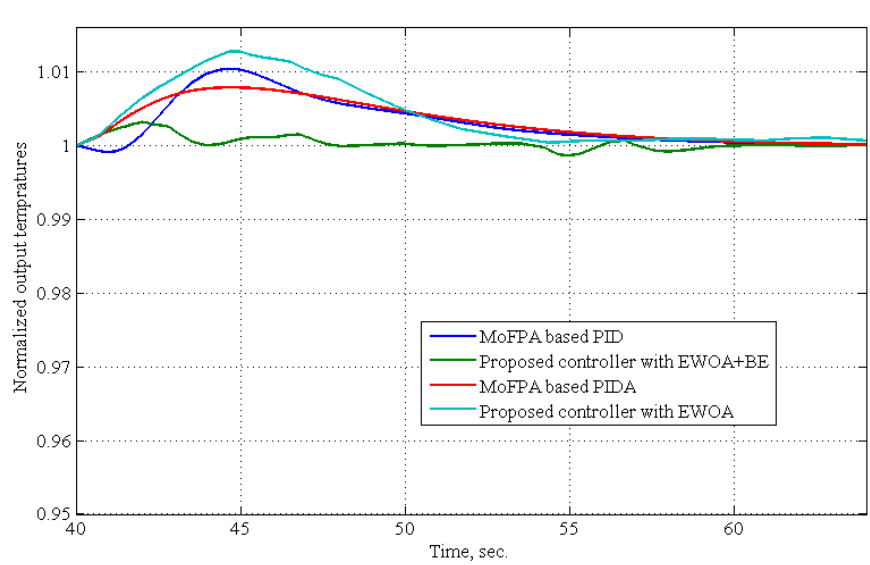
Figure 9. Step disturbance.